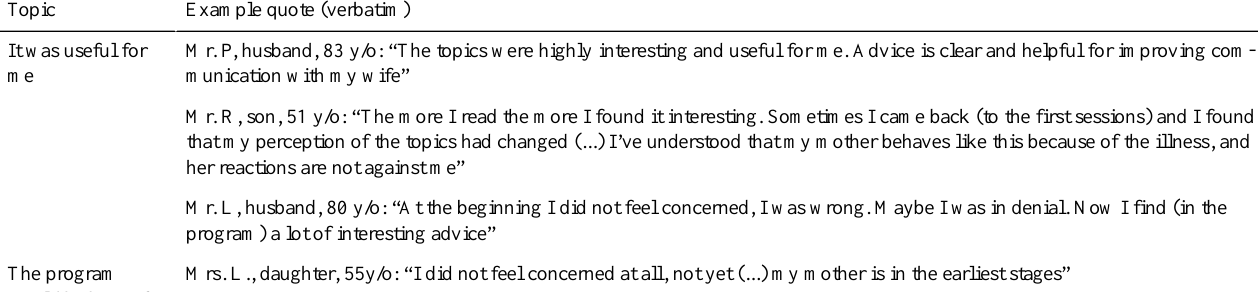
Table 4. Categories and examples of qualitative data. Example quote